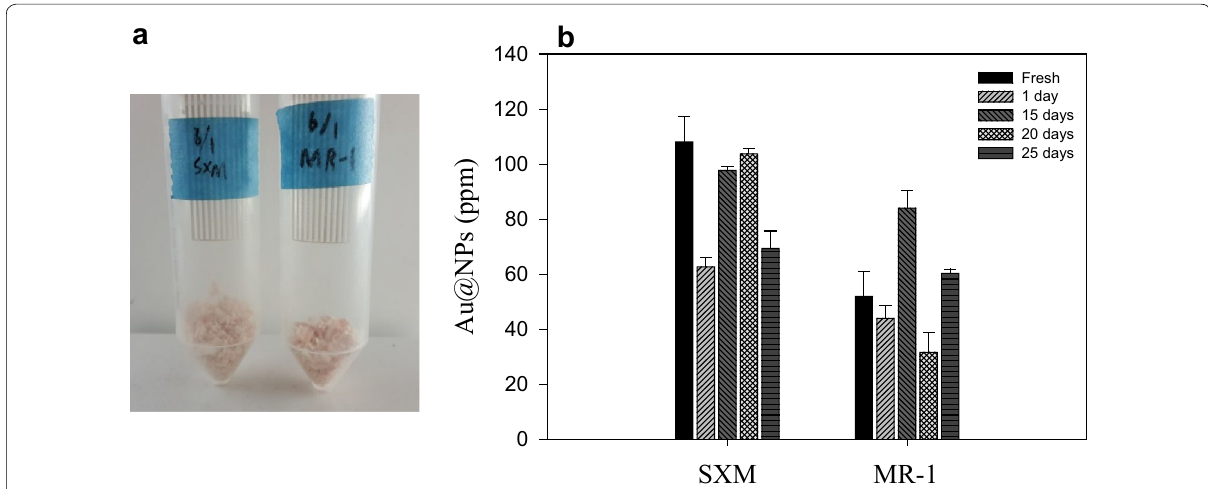
Fig. 5 a Resting Shewanella cells. b Biofabrication of Au@NPs by resting cells after 1, 15, 20, and 25